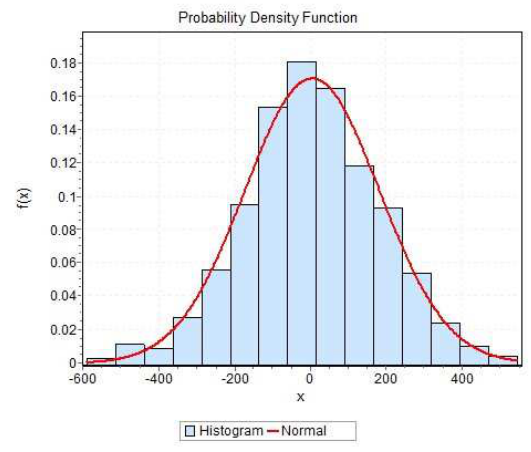
Figure 3. The tracking error distribution under the packets